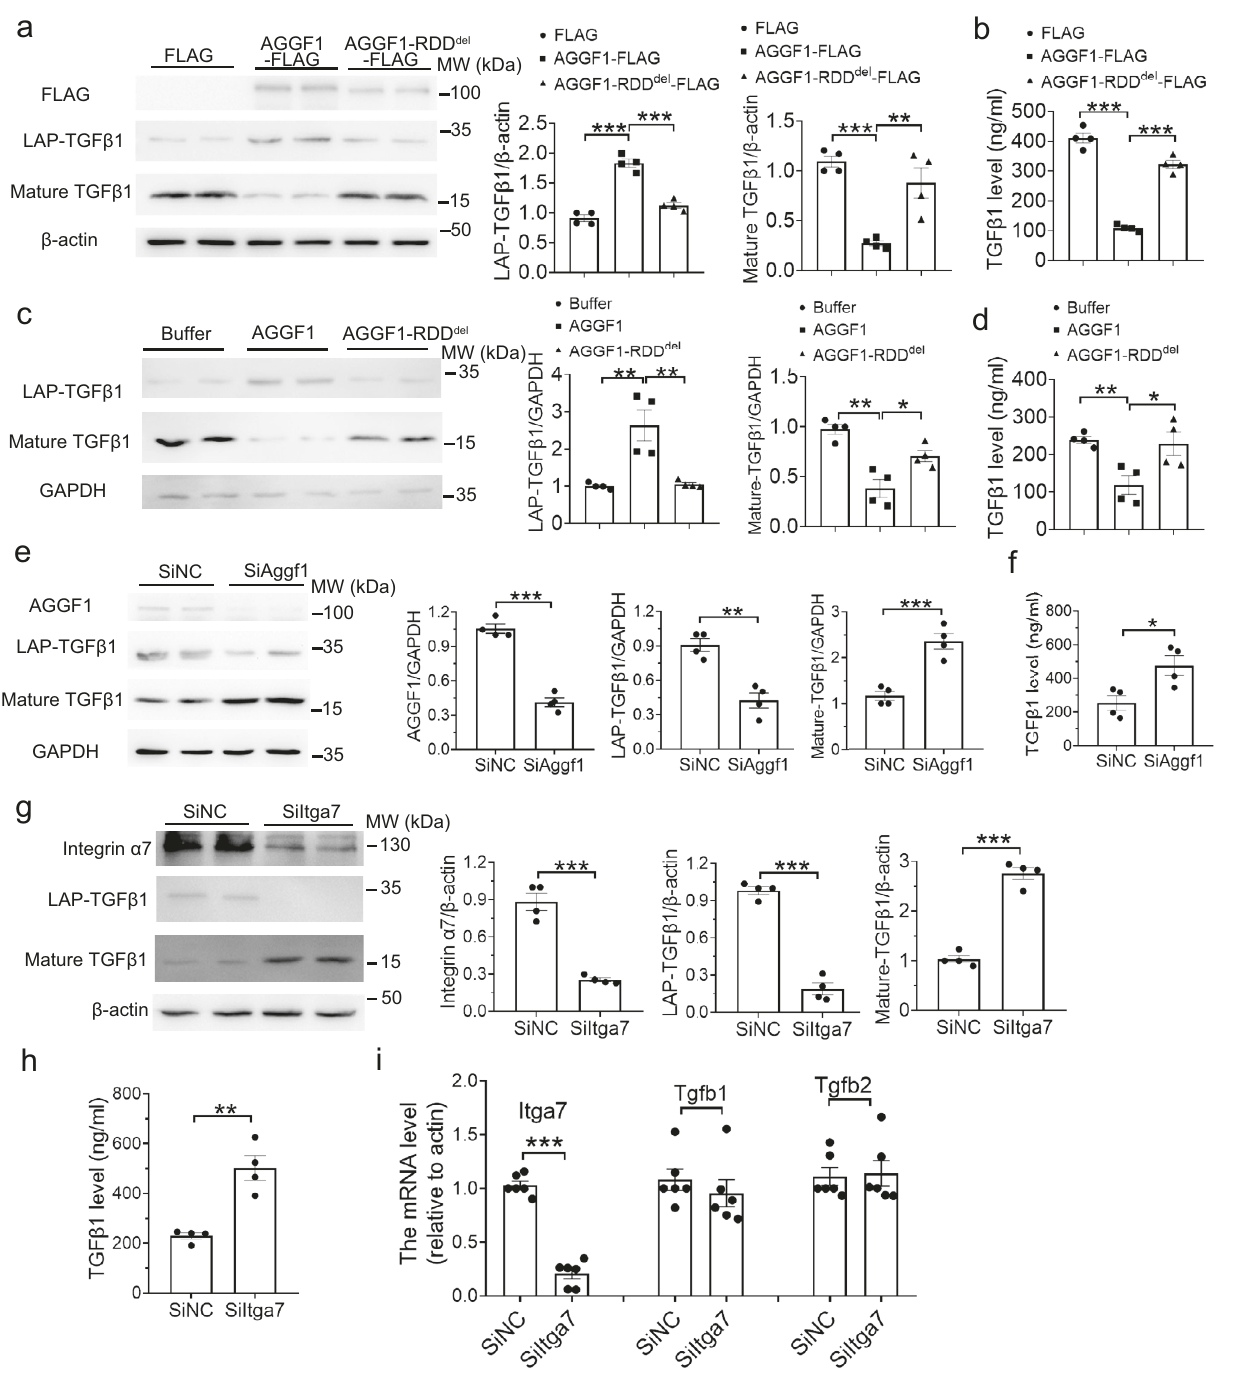
Fig. 5 | AGGF1 inhibits TGF- β 1 maturation and knockdown of Aggf1 or Itga7 induces TGF- β 1 maturation. a Western blot for LAP-TGF- β 1 and mature TGF- β 1 using VSMCs with overexpression of wild-type AGGF1 or mutant AGGF1-RDD del . β - actin was used as loading control ( n =4 experiments/group). b ELISA for mea- surementofTGF- β 1inculturemediafromVSMCswithoverexpressionofAGGF1or AGGF1-RDD del ( n =4 experiments/group). c Western blot for LAP-TGF- β 1 and mature TGF- β 1 using VSMCs treated with AGGF1 or AGGF1-RDD del for 48hours. GAPDH was used as loading control ( n =4 experiments/group). d ELISA for mea- surement of TGF- β 1 in culture media from VSMCs treated with AGGF1 or AGGF1- RDD del for 48h ( n =4 experiments/group). e Western blot for LAP-TGF- β 1 and mature TGF- β 1 using VSMCs transfected with SiAggf1 or SiNC ( n =4 experiments/